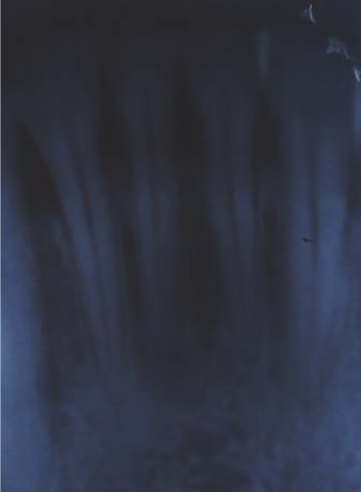
Figure 2: Radiograph in relation to lower anterior region showing absence of interdental bone loss.